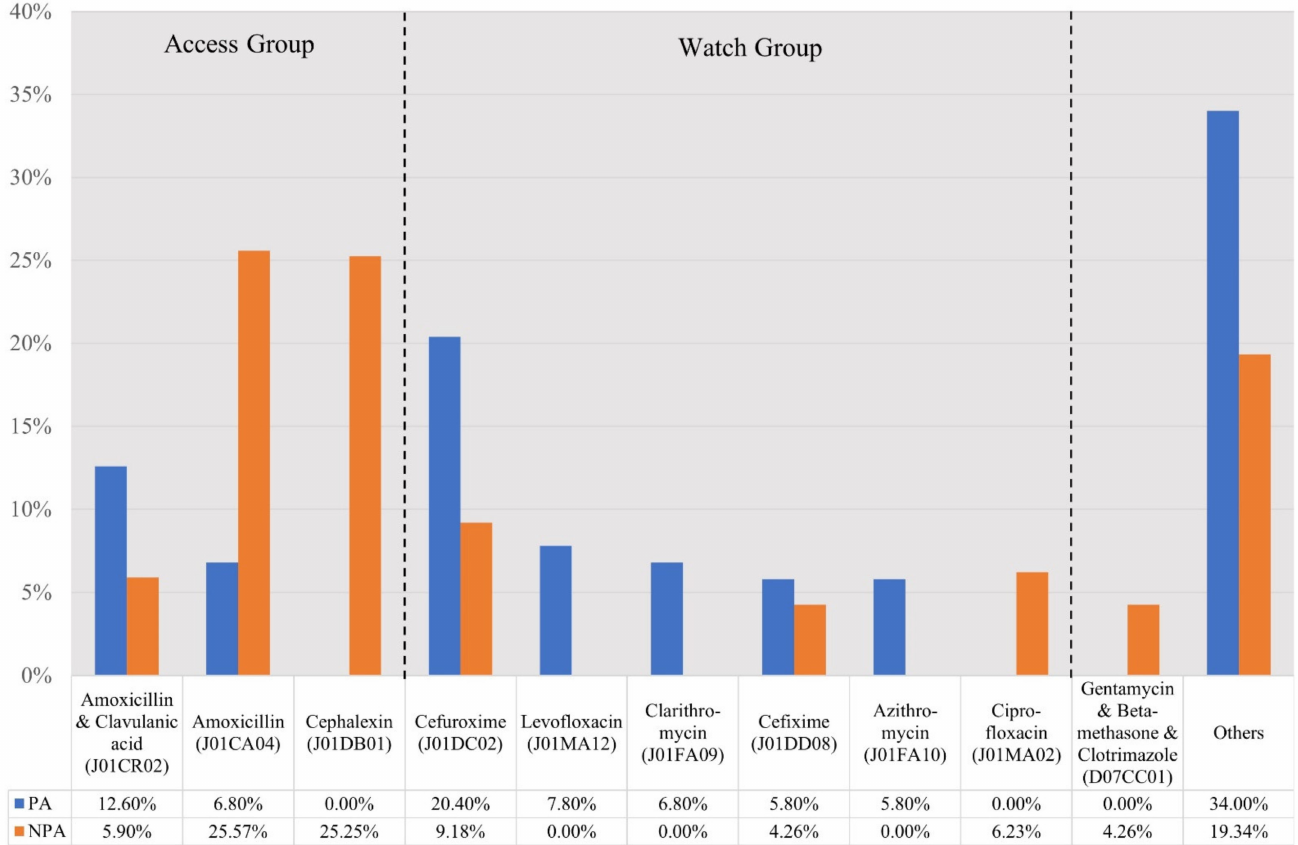
Figure 2. Types of antibiotics purchased with a prescription (PA group) and without a prescription (NPA group). NB. PA: antibiotics purchased with a prescription; NPA: antibiotics purchased without a